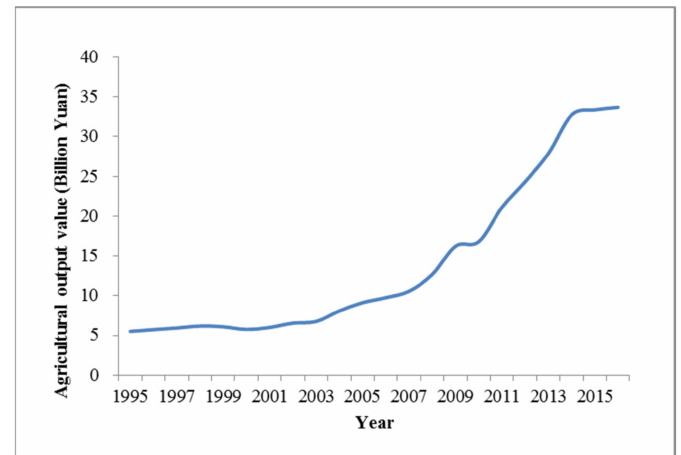
Figure 2. Agricultural output value in Qinghai province over